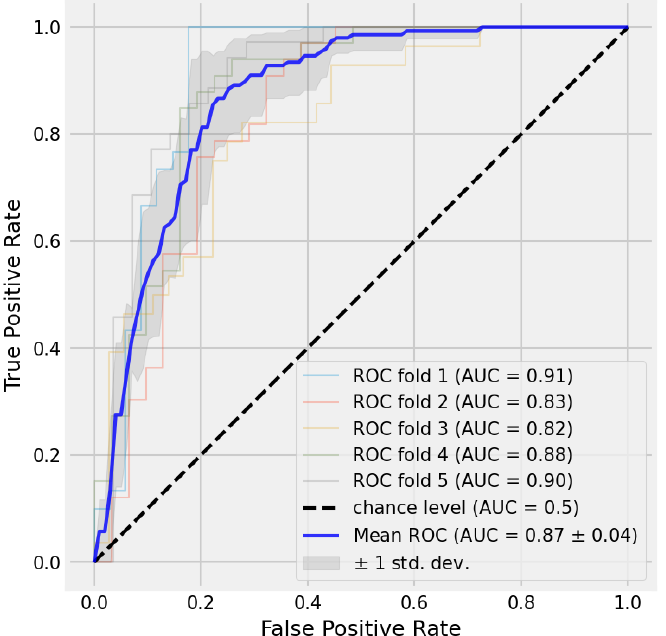
Figure 7. Receiver operating characteristic (ROC) curve for each fold. The mean ROC is shown in blue